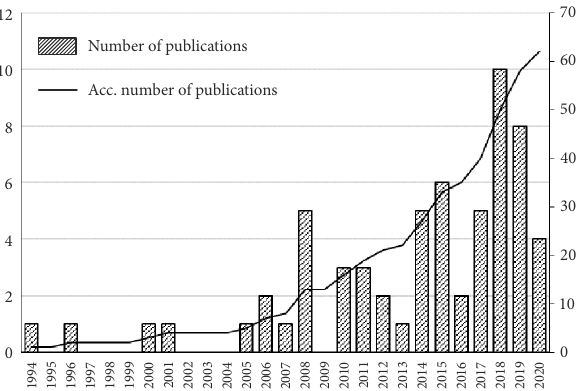
Figure 2. Distribution of publications over time (1994–2020)